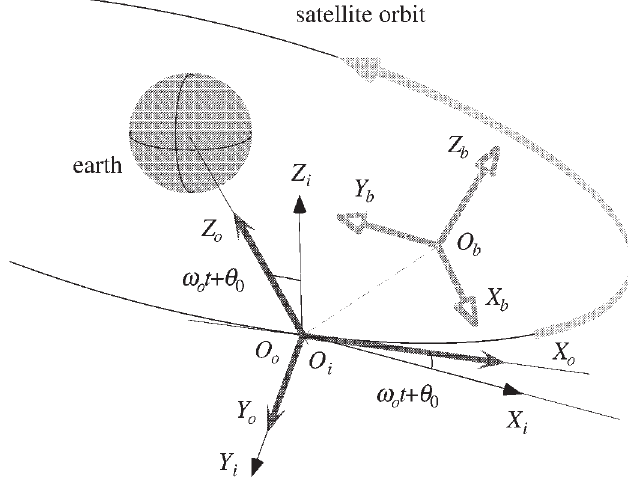
Fig. 1. The inertial reference frame F i ( O i X i Y i Z i ), orbital reference frame F o ( O o X o Y o Z o ), and main body fixed reference frame F b ( O b X b Y b Z b )